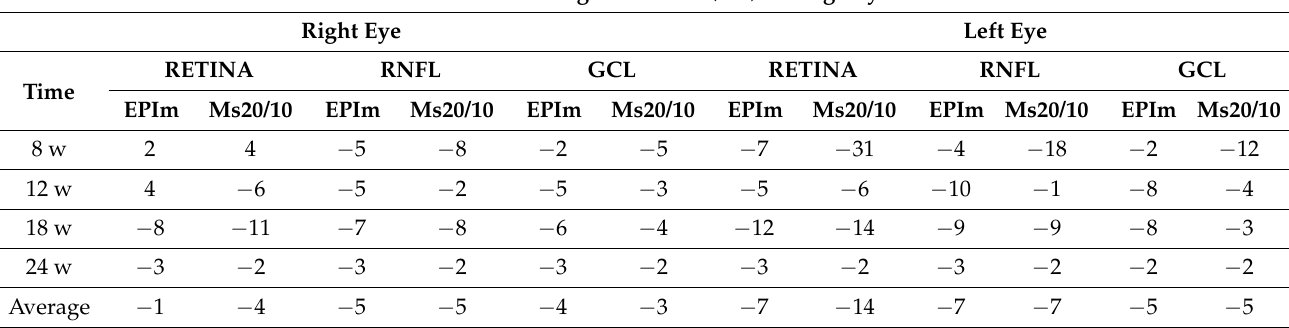
Table 3. Neuroretinal loss rate measured by optical coherence tomography in both ocular hypertensive models (episcleral and